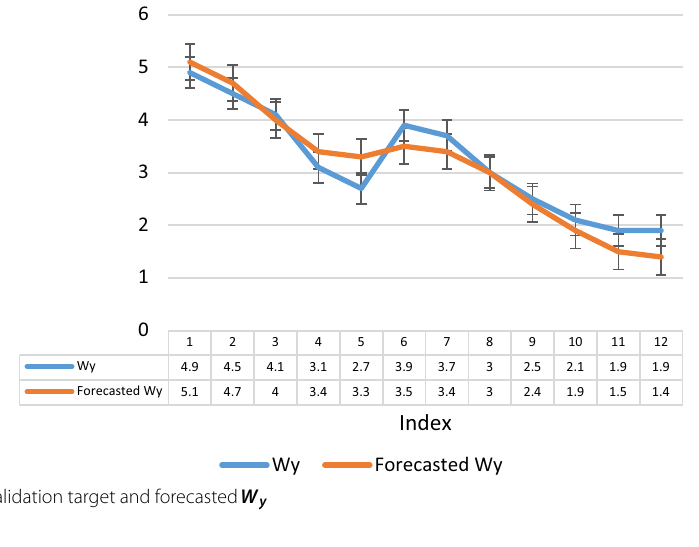
Fig. 27 Validation target and forecasted W y